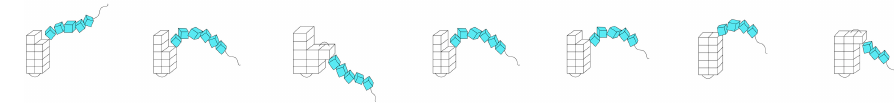
Figure 5. Illustration of the multi-path approach. Chain folding is allowed at each substep and further growth relies on the removal of unfavorable configurations such as the third.